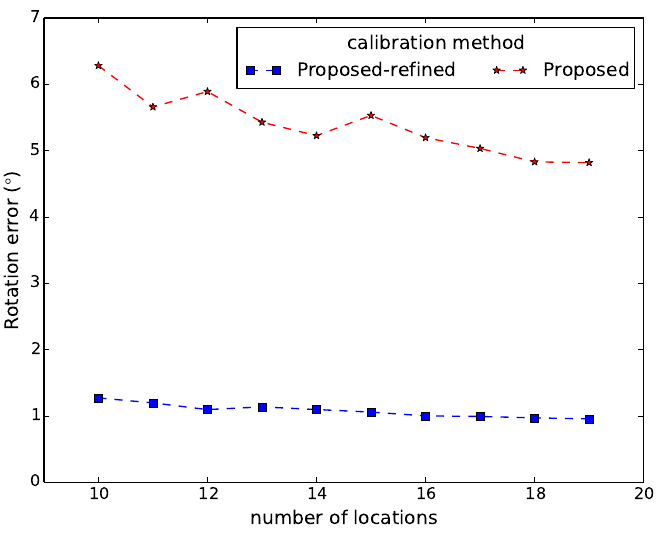
Figure 14. Relative rotation error of our method (proposed) and the method after refinement (proposed-refined) using different numbers of locations. Each location yields two calibration samples (head and